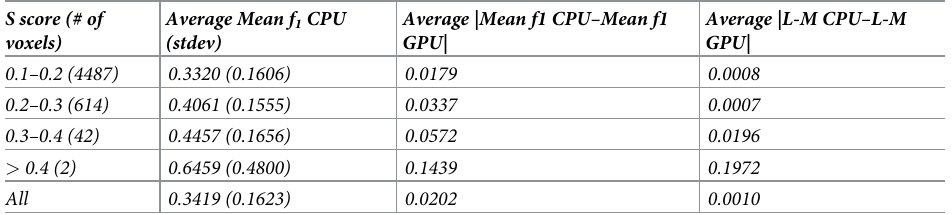
Table 1. Significantly different f 1